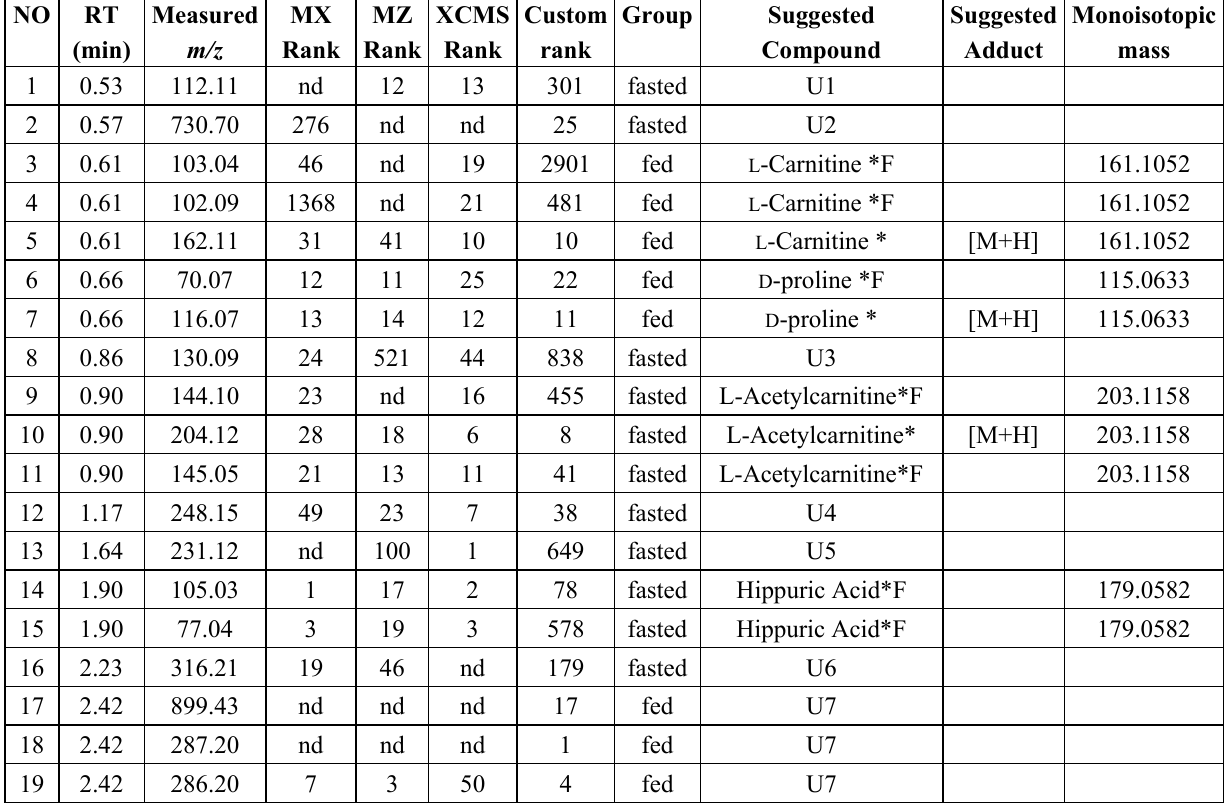
Table 2. Retention times and measured masses of the markers obtained from MarkerLynx, MZmine, XCMS and custom data processing of positive mode data that contributed most to the separation of samples in fasted and fed